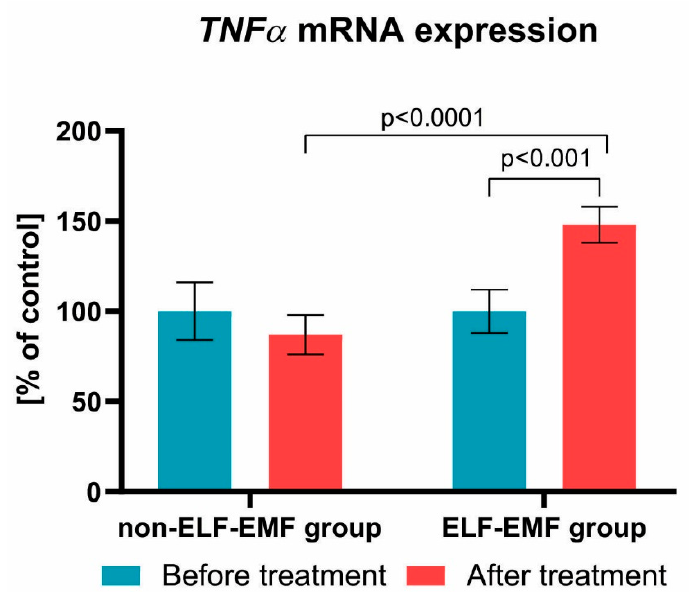
Figure 5. Comparison of the TNF α mRNA expression acquired from the study group vs. control group. Results formulated as parameter changes before and after therapy (100% expressed for the level of TNF α mRNA expression in each patient sample before treatment). Statistical significance between ELF-EMF and non-ELF-EMF groups after 10 sessions amount to p < 0.0001.